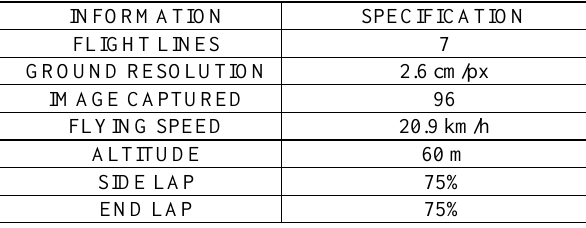
Table 2. Flight Planning Information